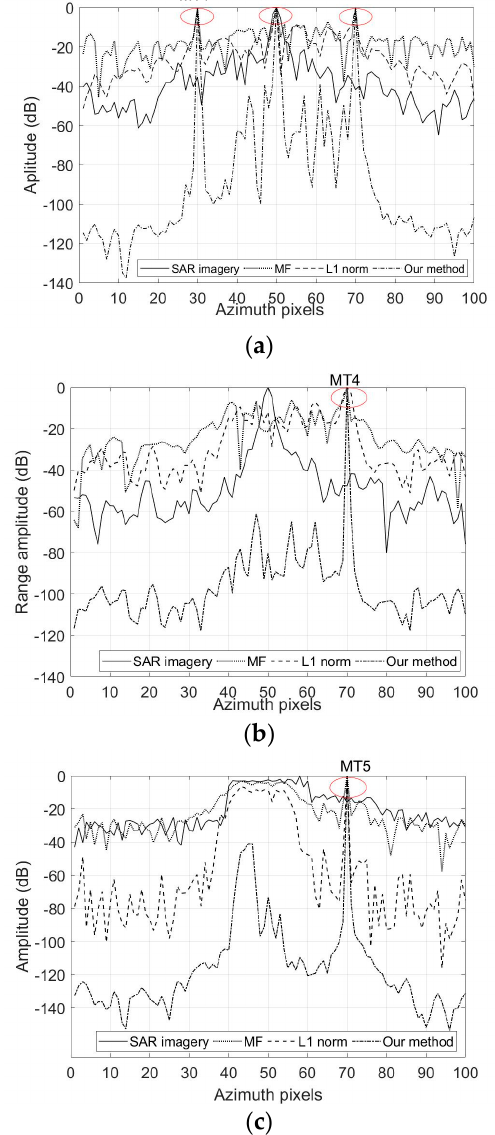
Figure 6. Comparison of the azimuth profiles of MTs before and after clutter suppression: ( a ) MT1, MT2, and MT3; ( b ) MT4; and ( c ) MT5.